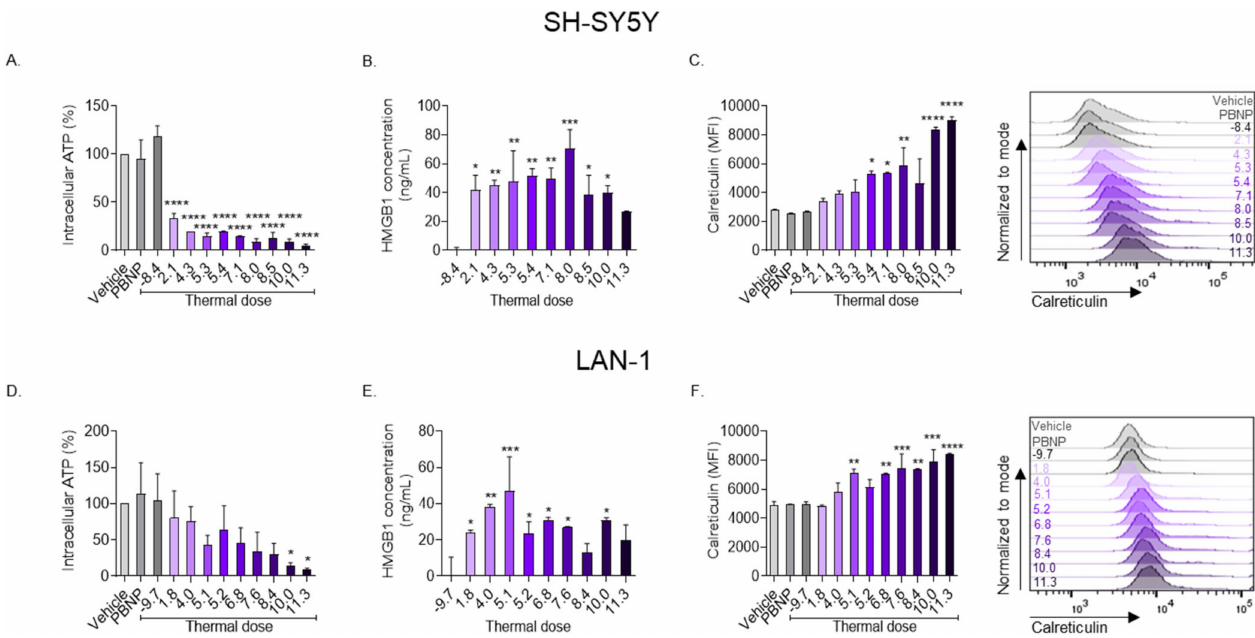
Figure 3. PBNP-PTT generates a thermal dose window of immunogenic cell death in SH-SY5Y and LAN-1 cells in vitro. Three million ( A – C ) SH-SY5Y or ( D – F ) LAN-1 cells were exposed to various thermal doses using PBNP-PTT. After 24 h, cells were analyzed for ( A , D ) intracellular ATP, ( B , E ) HMGB1 release, and ( C , F ) surface calreticulin expression, represented as median fluorescence intensity (MFI). Inset values in the histograms denote the thermal dose. The extent of ICD as measured by its correlates is more pronounced in SH-SY5Y cells compared with LAN-1 cells. Ordinary one-way ANOVA was used to calculate significance between vehicle and different thermal doses and laser alone for HMB1 analysis. n = 2/group; * p < 0.03, ** p < 0.002, *** p < 0.0002, **** p <